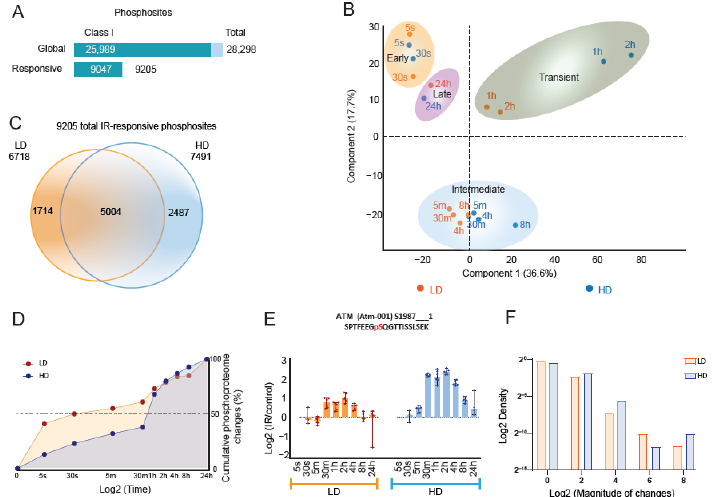
Figure 1. IR dose-dependent phosphoproteome dynamics: ( A ) Statistics of phosphosites quantified in IB10 mouse ES cells. Phosphosites quantified and those that responded to DNA damage are depicted in the top and bottom bars, respectively. Light bar indicates total phosphosites and the dark bar indicates class I phosphosites (>0.75 phosphosite localization probability). ( B ) Principal compo-nent analysis (PCA) map of log2 SILAC ratios of total responsive phosphosites after LD (orange dots) and HD (blue dots) exposure over unirradiated controls. Four groups are readily visible. ( C ) Venn diagram of 9205 phosphosites that responded to LD (orange circle) and HD (blue circle). ( D ) Temporal dynamics showing the timing of phosphoproteome changes in LD- and HD-exposed mESCs. ( E ) Bar charts showing quantifications of ATM phosphosite pS1987 in response to LD and HD. Dots and bars represent quantifications and median values of up to six replicates, respectively, and error bars represent a 95% confidence interval (CI). ( F ) Density plot showing the distribution of the magnitude of global phosphoproteome changes in LD- and HD-exposed cells.